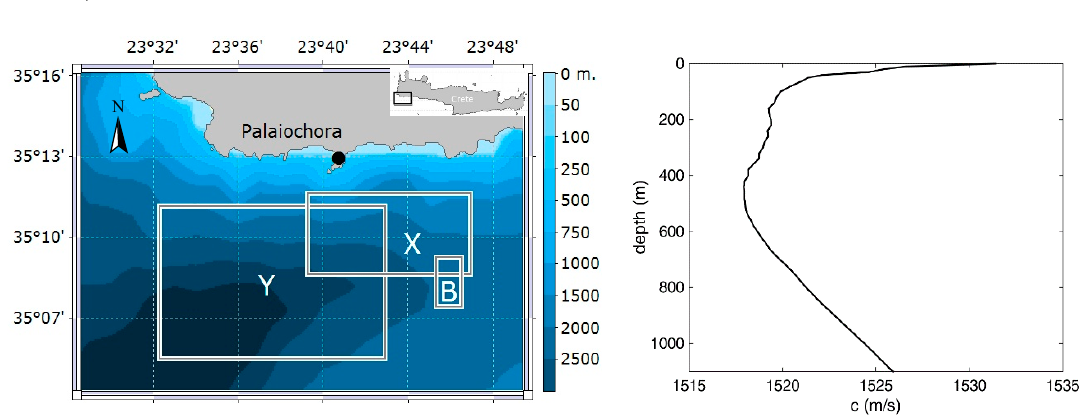
Figure 2. Predicted geometry of direct ( bottom left ) and surface-reflected ( top left ) acoustic rays from a source at a depth of 160 m in the sound speed profile of Figure 1. Area where the TDOA between direct and surface-reflected arrivals is larger than 7 ms ( right ). The colors in that area denote the ray- theoretic transmission loss (TL)—scale on the right in dB—without absorption.